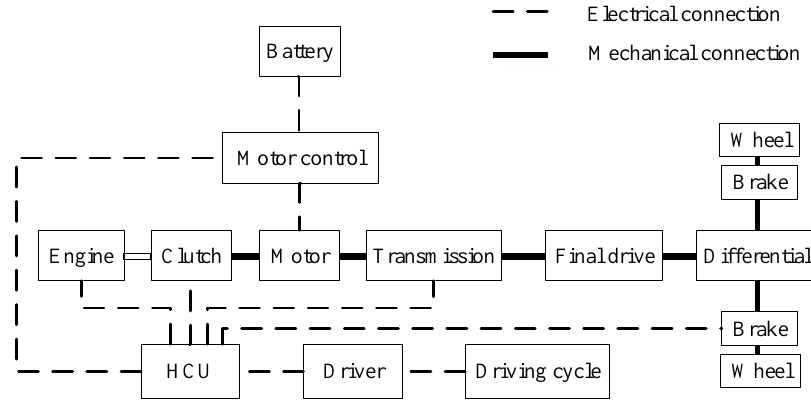
Figure 1. Simulation configuration of the researched HEV.